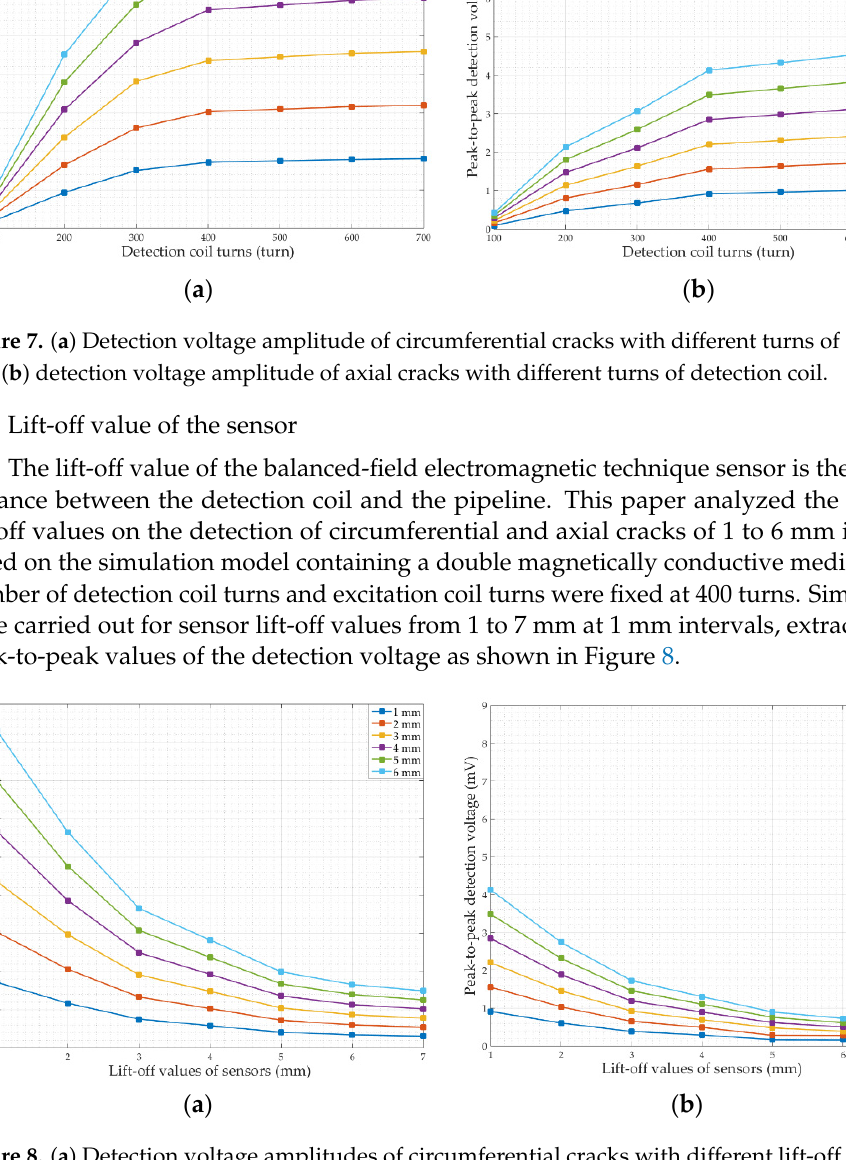
( b ) Figure 6. ( a ) Detection voltage amplitude of circumferential cracks with different turns of excitation coil; ( b ) detection voltage amplitude of axial cracks with different turns of excitation coil. Next, the number of the detection coil turns was analyzed. According to 2.3, the num- ber of the excitation coil turns and the number of the detection coil turns have different effects on the sensitivity and the detection coil does not influence the excitation structure of the sensor. Therefore, the analysis of the optimal parameters of the detection coil can be carried out based on the optimal number of the excitation coil turns determined above. It was simulated for different turns of the detection coil that the detection of circumferen-